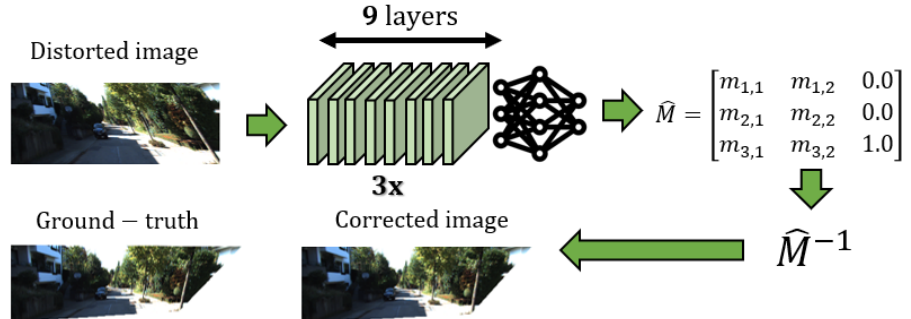
Figure 1. Given a distorted input image, three convolutional neural networks are used for producing ˆ M transformation matrix that caused the distortion ( M as ground-truth matrix). The distorted image is transformed to its corrected image by applying ˆ M − 1 .